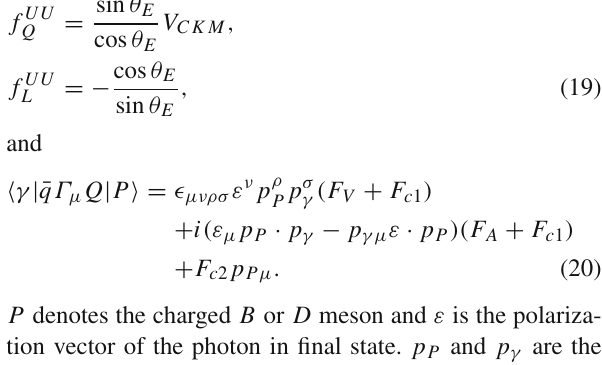
Fig. 1 The Feynman diagrams of the radiative leptonic decays of charged B and D mesons at tree level in the